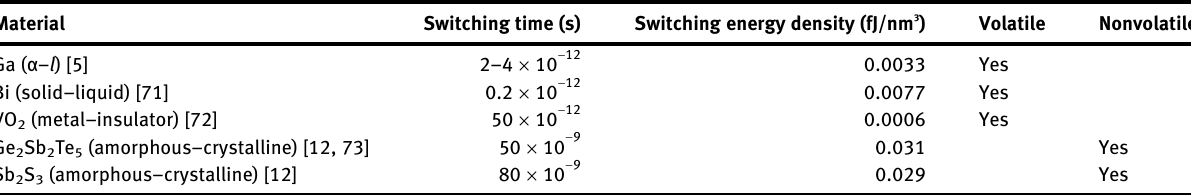
Table  : Switching time, switching energy density, volatility, and bandgap of the considered materials in the comparison.